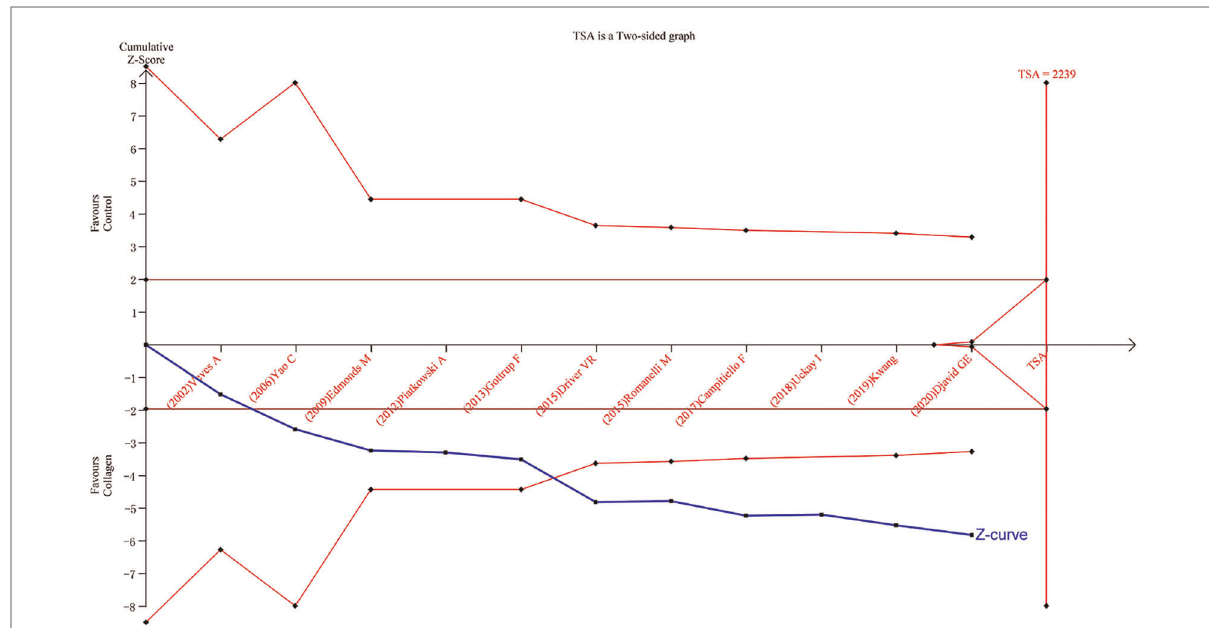
FIGURE 8 Results of TSA with the primary outcome. The required information size was calculated based on a two-side α =5%, power 80%, and a relative risk reduction of